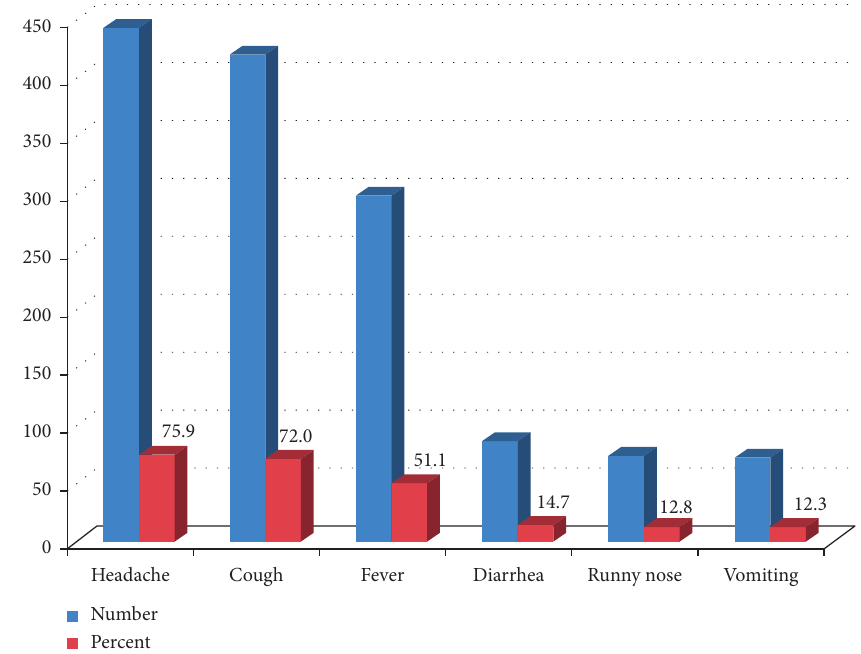
Figure 1: Signs and symptoms observed in the study participants at Amhara region COVID-19 treatment. Table 2: Baseline clinical features of COVID-19 patients admitted to Amhara region COVID-19 treatment centers, 2021 ( n � 622).